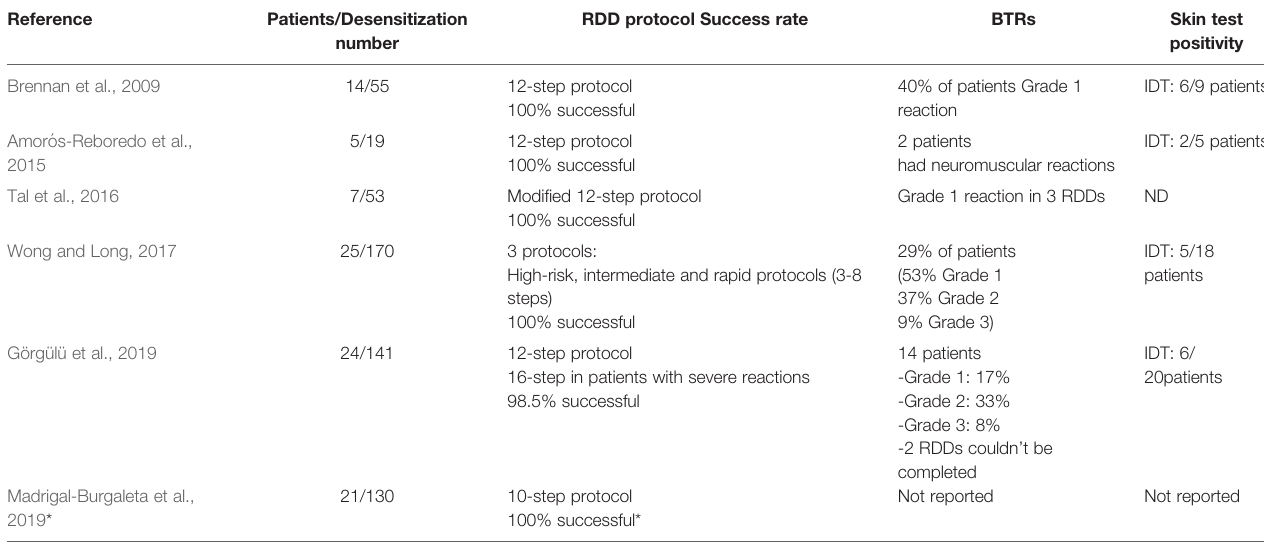
TABLE 3 | Rapid desensitization protocols data from different studies.